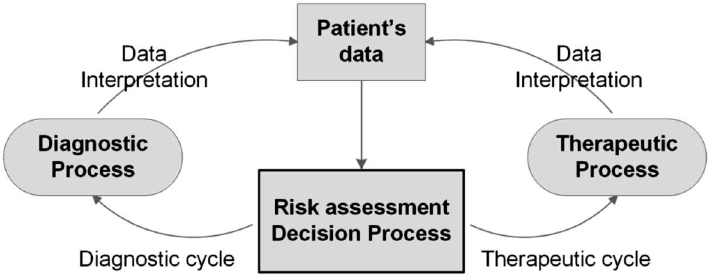
Figure 1. Decision Making Process Diagram (Risk Assessment)